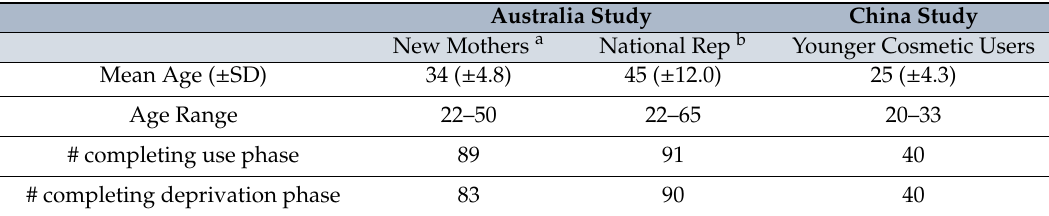
Table 1. Demographics of Study